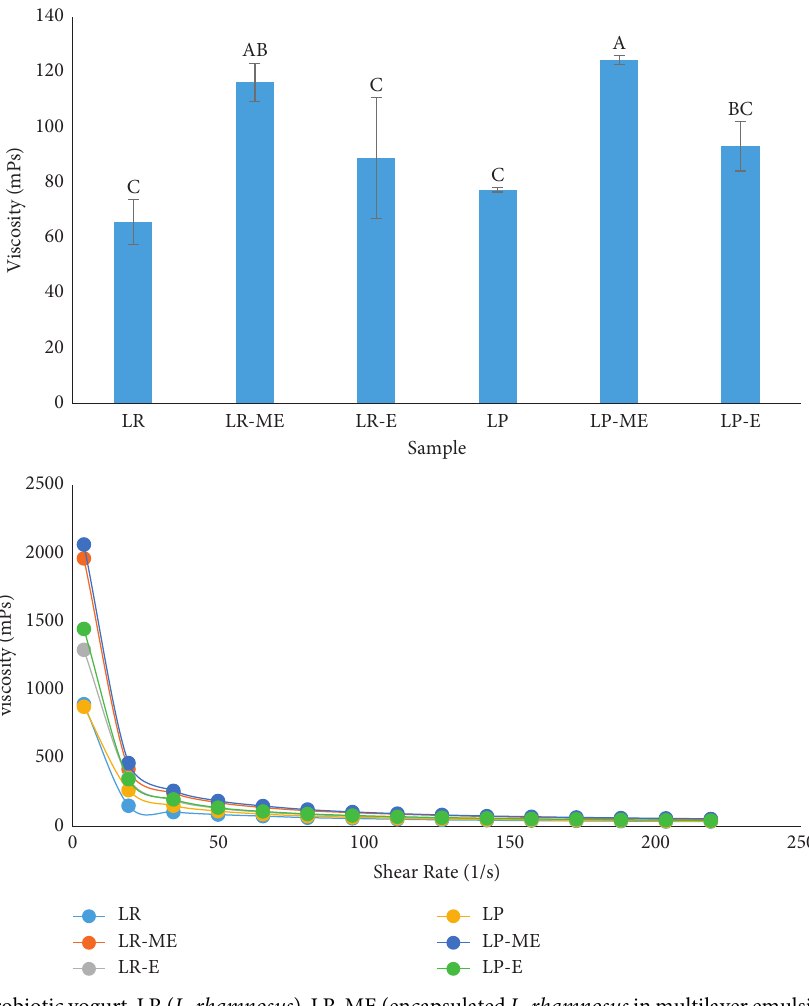
Figure 6: Viscosity of probiotic yogurt. LR ( L. rhamnosus ), LR-ME (encapsulated L. rhamnosus in multilayer emulsion), LR-E (encapsulated L. rhamnosus in emulsion), LP ( L. plantarum ), LP-ME (encapsulated L. plantarum in multilayer emulsion), and LP-E (encapsulated L. plantarum in emulsion).